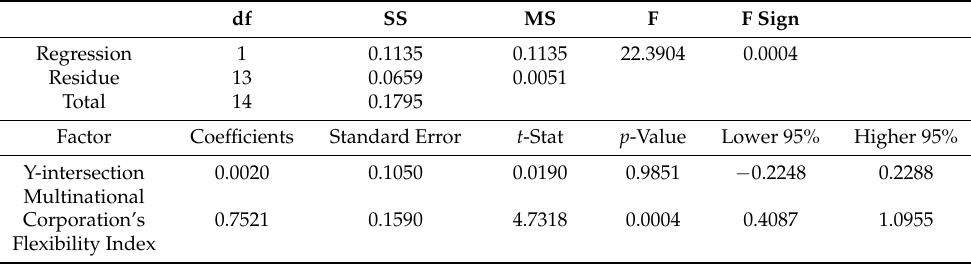
Table 3. Results of variance analysis of the relationship between multinational corporations’ energy flexibility and their development level.